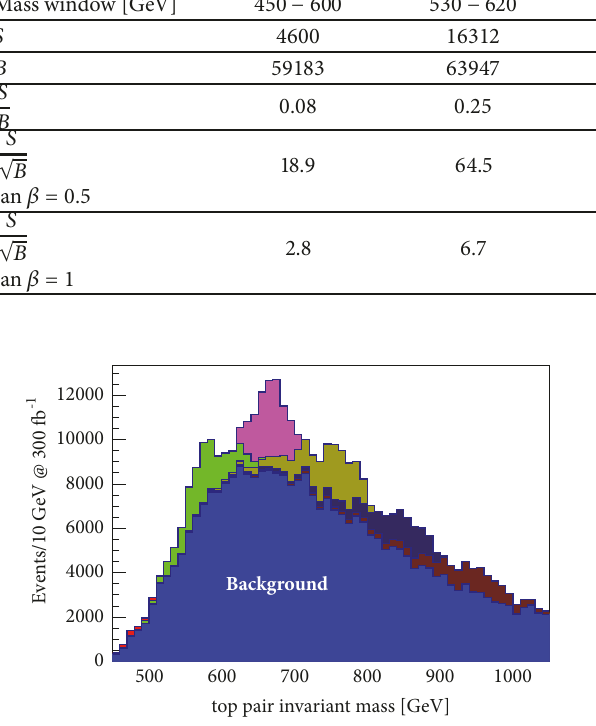
Figure 5: The signal distributions on top of the total background (shown in blue). The signal from Higgs boson masses in the range 500-1000 GeV is shown in different